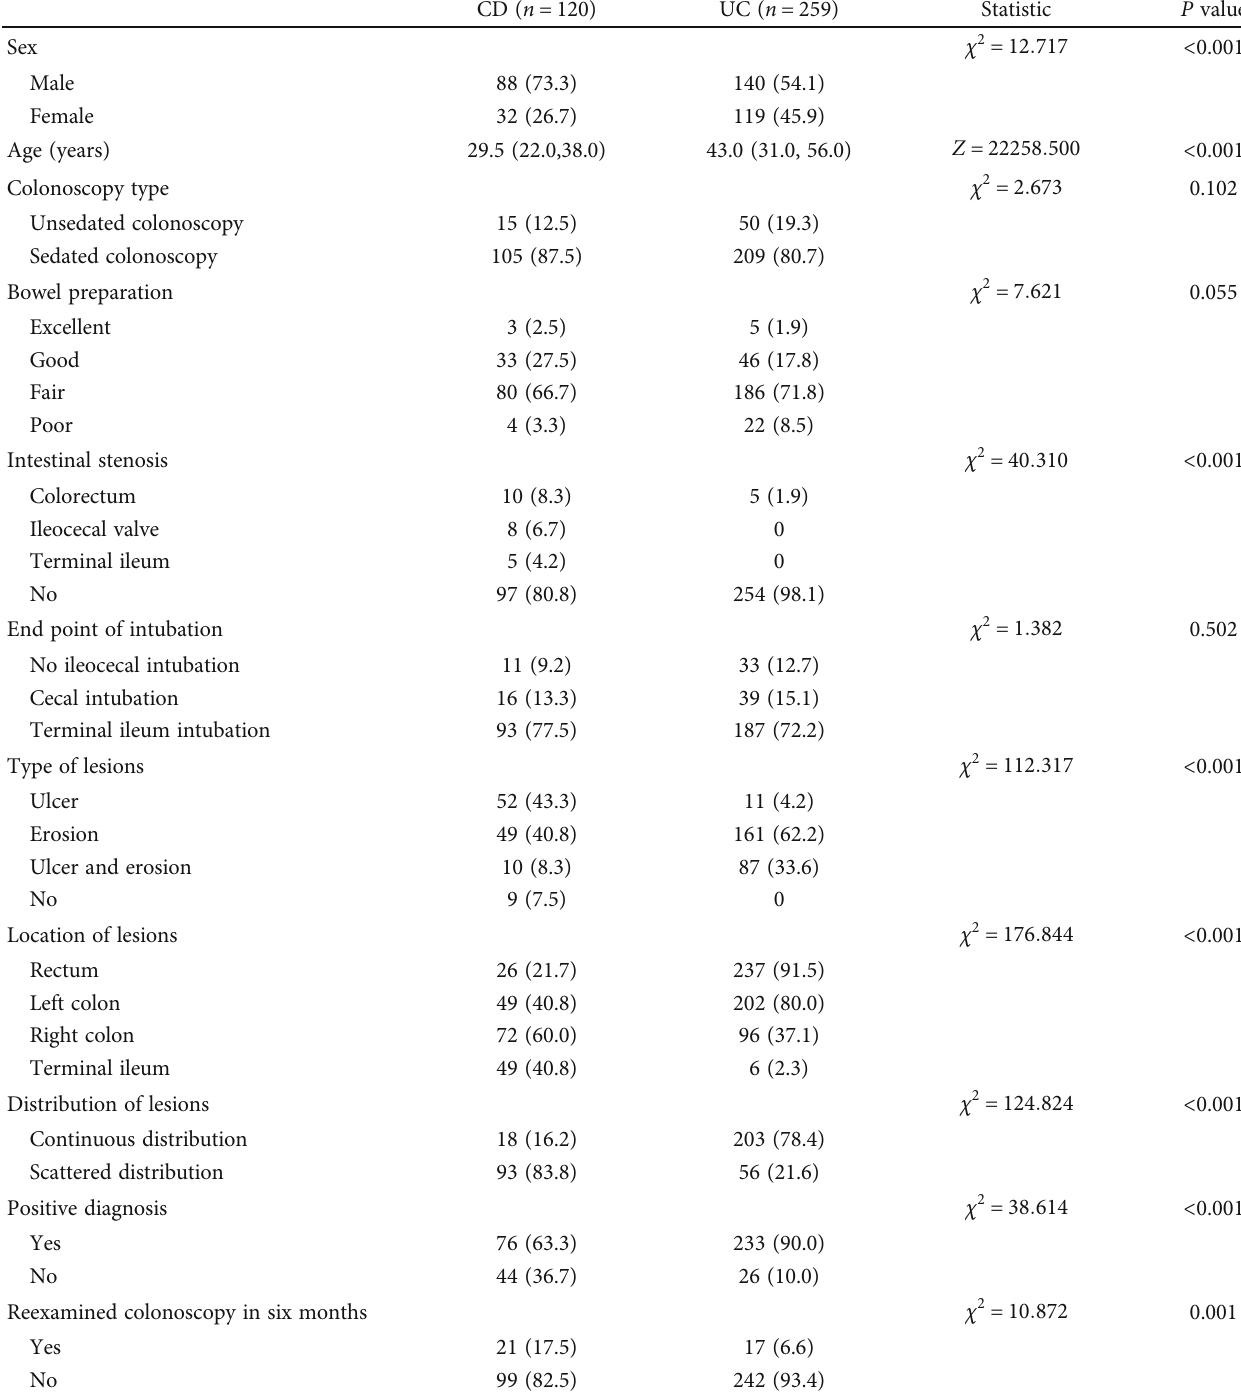
Table 1: Comparison between the baseline and colonoscopy data of patients with CD and those with UC. CD ( n = 120